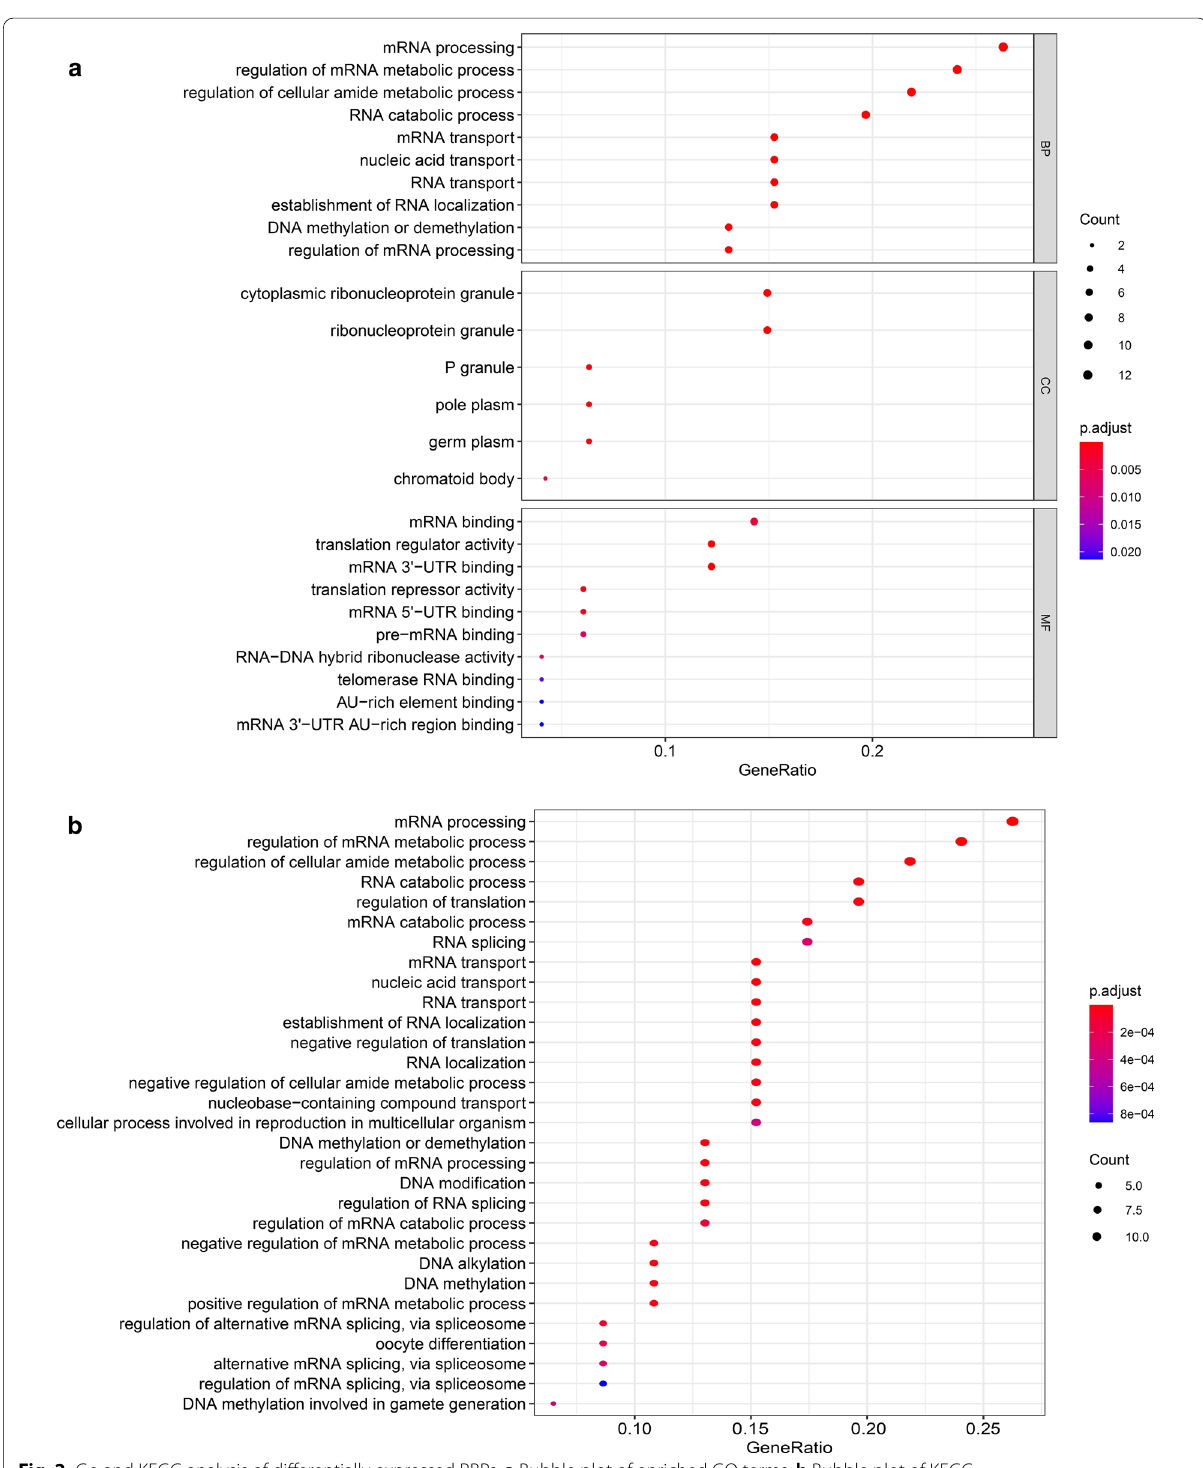
Fig. 2 Go and KEGG analysis of differentially expressed RBPs. a Bubble plot of enriched GO terms. b Bubble plot of